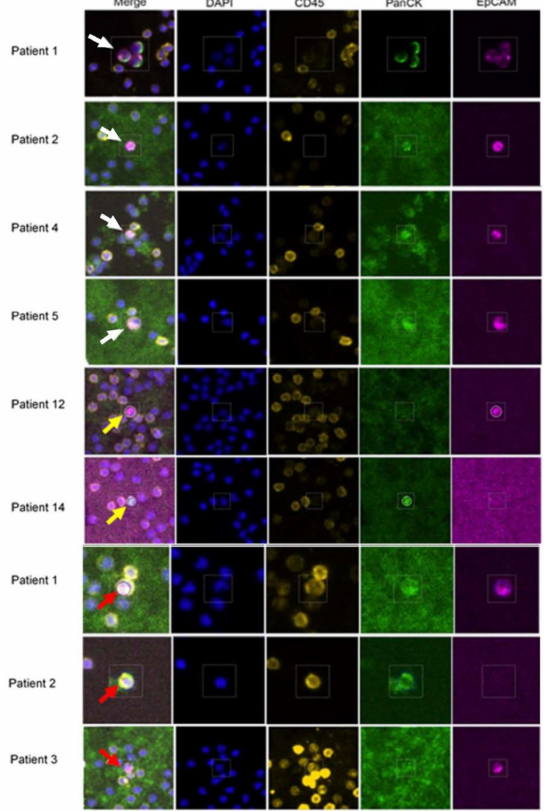
Figure 2. Immunofluorescence identification of CTCs from patients using the Cytefinder II platform. Cells were isolated from mBC blood samples as detailed in the methods. CTCs identified by EpCAM (magenta) and pan-cytokeratin (green) positive staining were visualized as single cells (patient 2), as associated with CD45+ cells (yellow) (patient 3, 4, 12, 14), or as multiple CTCs clustered together (patient 1, white arrow). CTCs marked with a yellow arrow are either CTCs that EpCAM+/CK − (patient 12) or EpCAM − /CK+ (patient 14). The CTCs marked with a red arrow are cells that are either EpCAM+/CK+/CD45+ (patient 1) or CK+/CD45+ (patient 2). Each CTC in a cluster was enumerated separately, and given a distinct cell identification